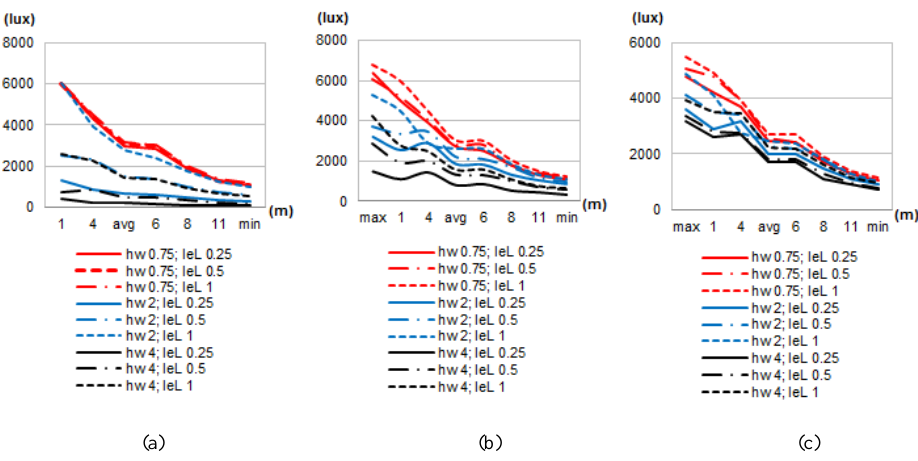
Fig. 6. E i of a 12 m wide room equipped with north-oriented windows with lightshelves in Yogyakarta with varying urban geometry under clear sky on June 12 at 12 noon on the first floor (a), the third floor (b) and the fifth floor (c). Under overcast sky conditions, the effects of h / w on the E i of the first floor were stronger than those of le / L . Variation in le / L only produced significant effects on the E i near the window in the urban area with medium or high h / w . Generally, it produced only small effects if the urban area had low h / w . On the third floor the effects of h / w on the E i of the 12 m wide room were more pronounce than those of le / L . A similar pattern with slight effects of the urban geometry on the third floor occurred on the fifth floor.